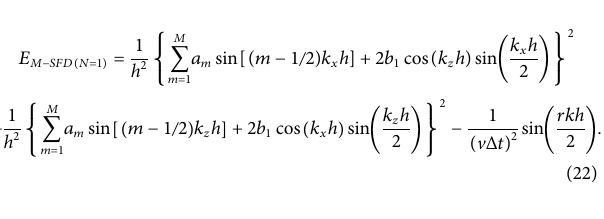
Frontiers in Earth Science |